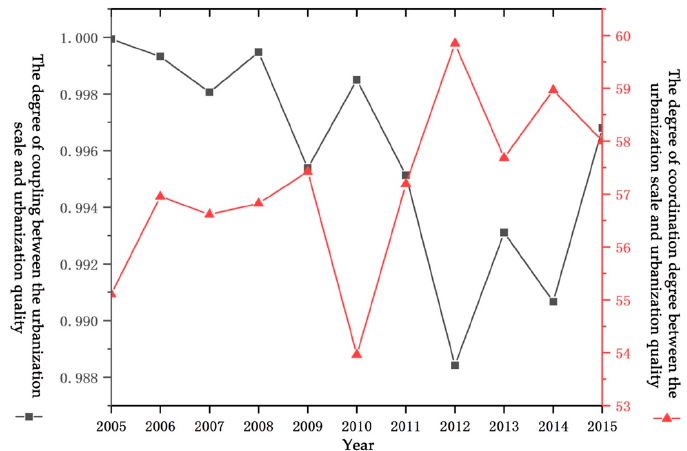
Figure 2. Overall urbanization coordination level in China from 2005 to 2015.